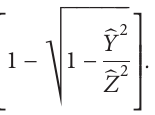
, 􏽢 z , and 􏽢 p (markers will be described 1 0